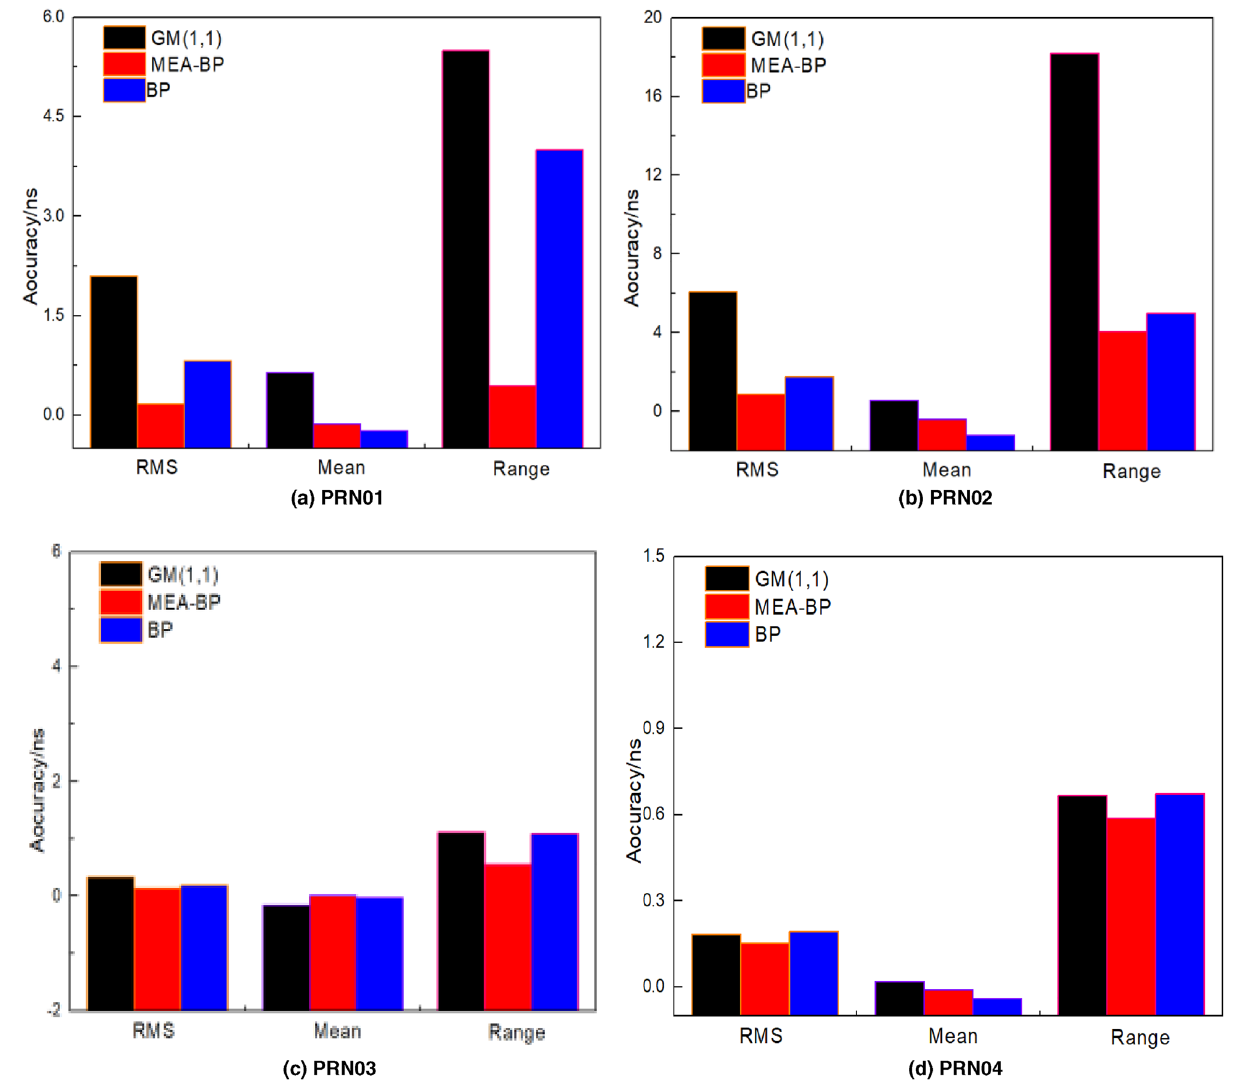
Figure 8. Prediction bar chart of 12 h clock bias of the seven